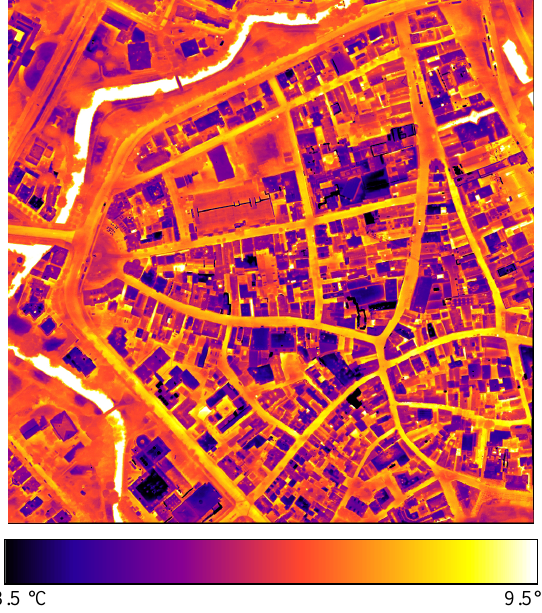
Figure 1: A 500 m x 500 m subset thermal infrared orthorectified image section of Oldenburg, Lower Saxony. The spatial resolution is about 50 cm.